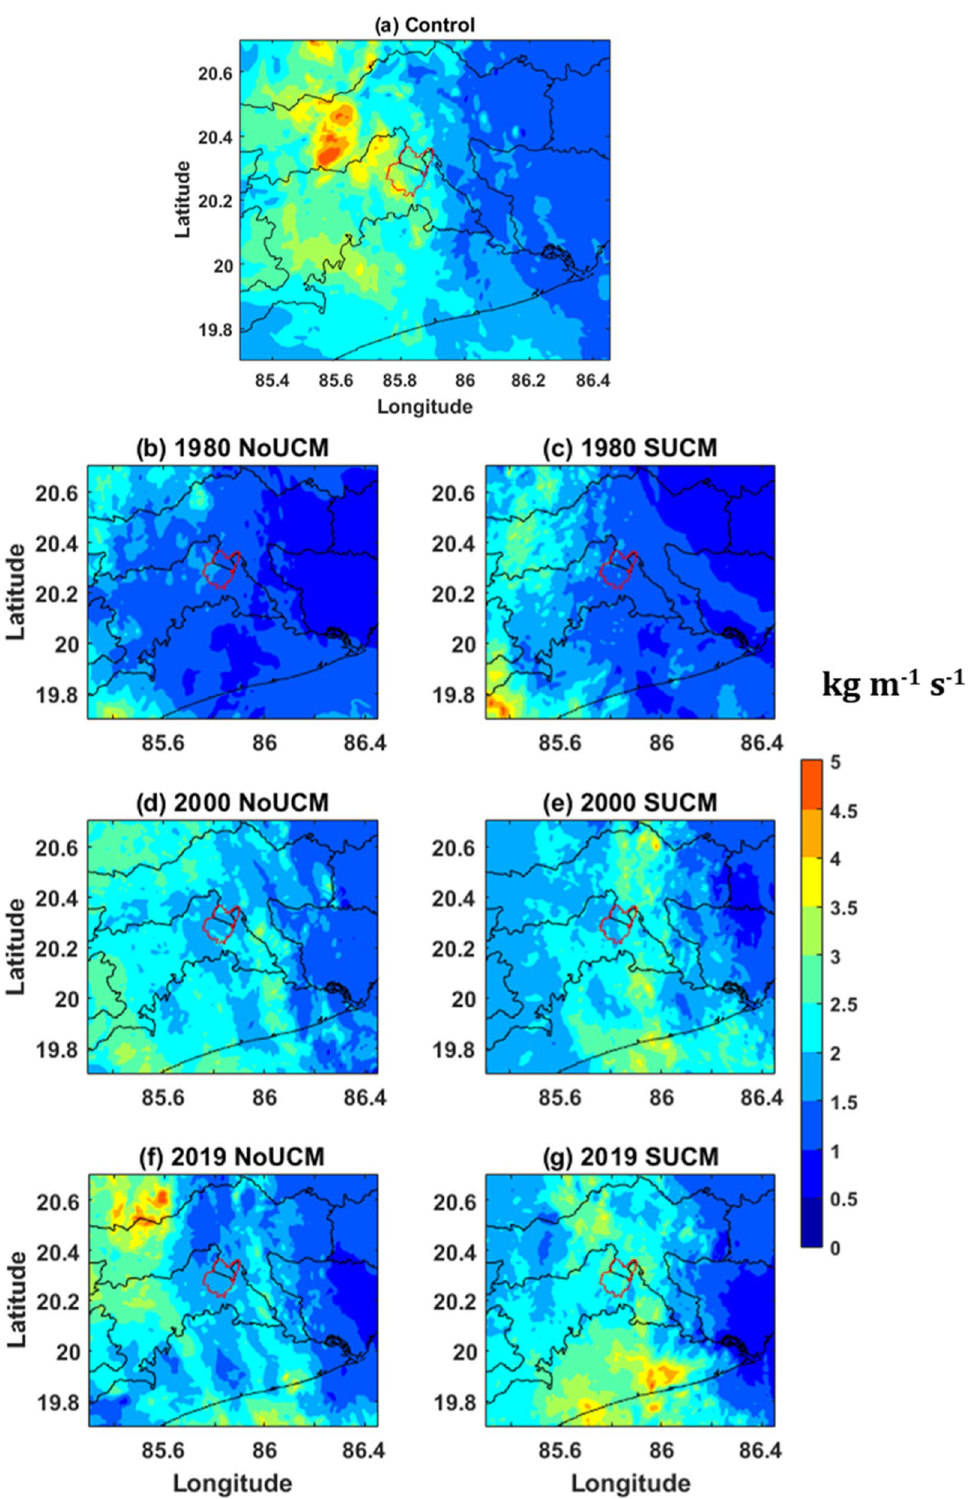
Fig. 7 Vertically integrated moisture flux (kg m-1 s-1) for 20072018 case a control run, b 1980 NoUCM, c 1980 SUCM, d 2000 NoUCM, e 2000 SUCM, f 2019 NoUCM, and g 2019